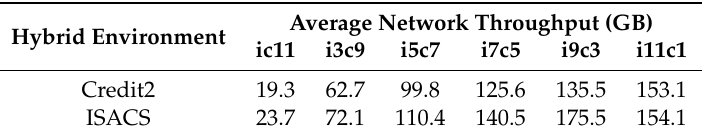
Figure 9. Distribution of the network throughput of each scheduler for 15 iterations of each experiment with a different VM configuration in the hybrid environment. Table 5. Average network latency according to the VM configuration based on Figure